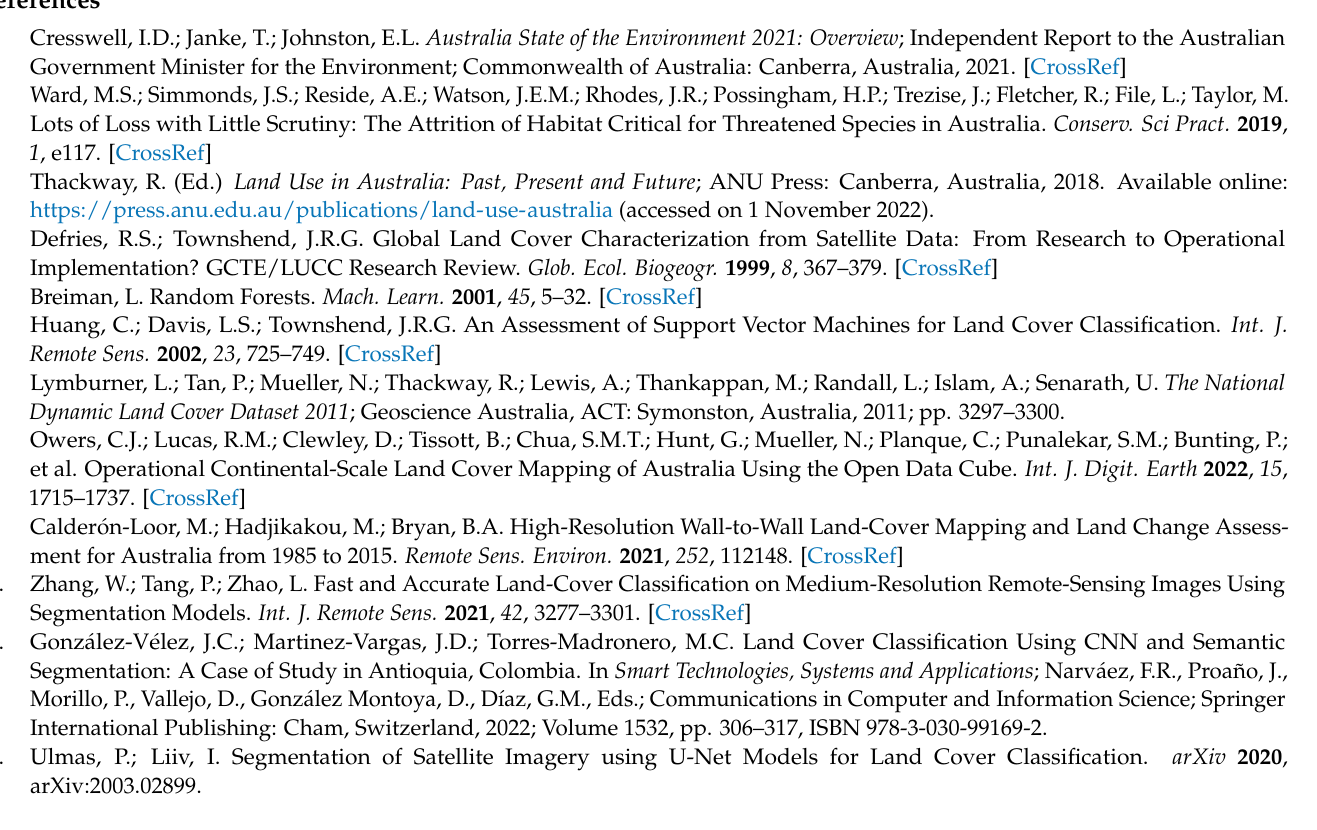
DEA Land Cover (c) and input Landsat data as True colour RGB (a) for Canberra urban area in 2013; Figure S3: 2017 simplified U-Net CNN Model (a), simplified ESRI Land Cover (b) and differences (c). Difference map shows ESRI Land Cover classes where they are different to the U-Net CNN model; Figure S4: Relationship between ESRI Land Cover and U-Net CNN model for Built area vs. Built-up (a) and Trees vs. Forest + Plantation (b). Other classes are less well